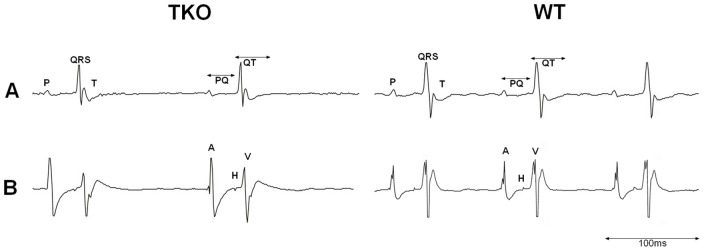
Representative ECG recordings of TKO and WT mice.A: Surface ECG. B: Intracardiac ECG at His–bundle level (A: first intracardiac atrial signal. H: His signal. V: first intracardiac ventricular signal).